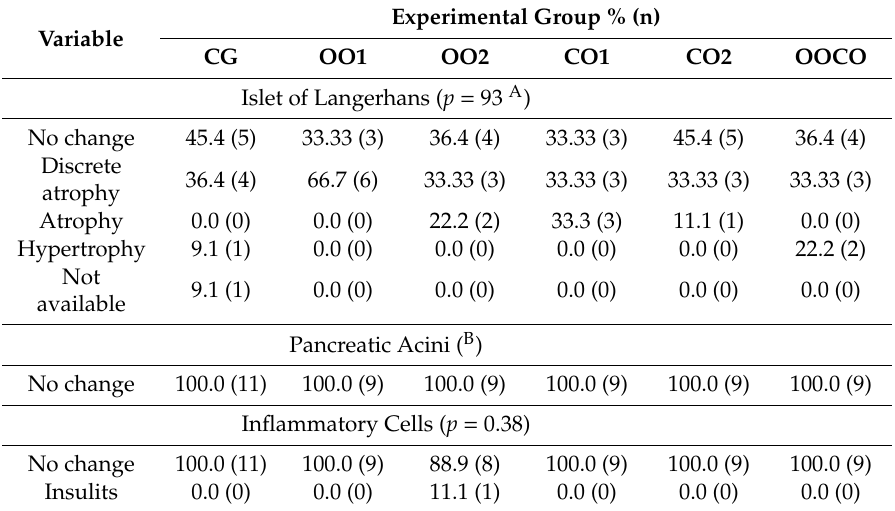
Table 6. Distribution of changes observed in animal pancreas in each experimental